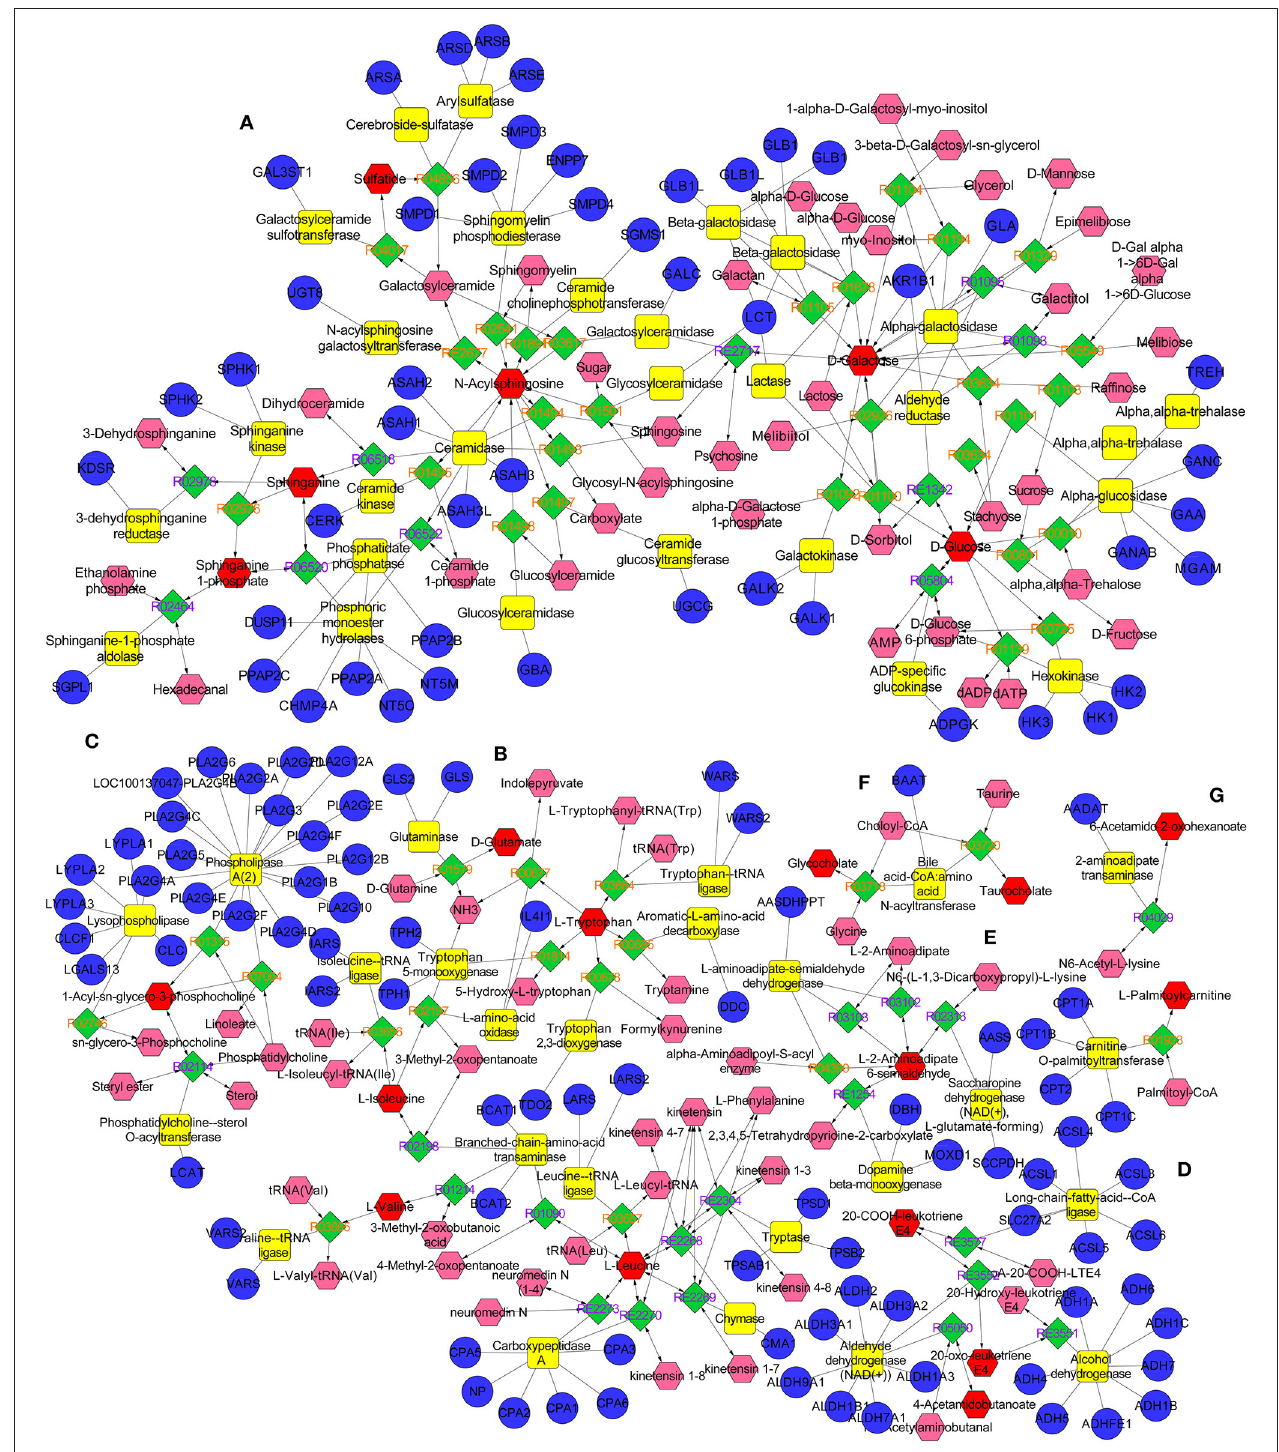
FIGURE 11 | The metabolic networks involved in enzymes and genes were established based on the differential metabolites in both CUMS and healthy rats following PBR treatment. The metabolic networks of sphingolipid metabolism (A) , glycometabolism (A) , amino acid metabolism (B,E) , glycerophospholipid metabolism (C) , fatty acid metabolism (D,G) and bile acid metabolism (F)